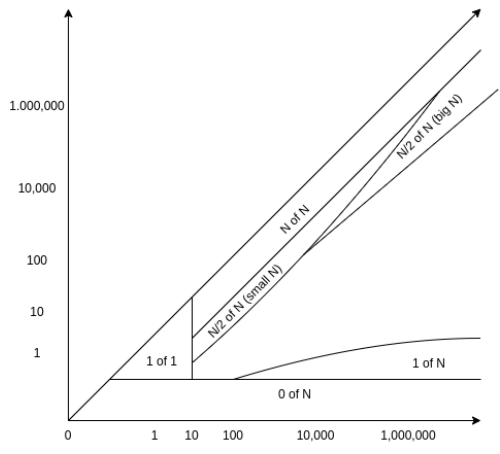
Figure 6. The different trust